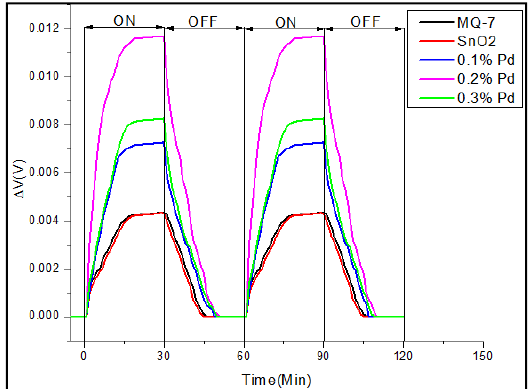
Figure 9. Change in voltage for eight sensor array of pure SnO 2 as well as with di ff erent concentrations 0.1%, 0.2%, 0.3% of palladium and commercial CO sensor MQ-7, during repeatability test @1000 rpm.